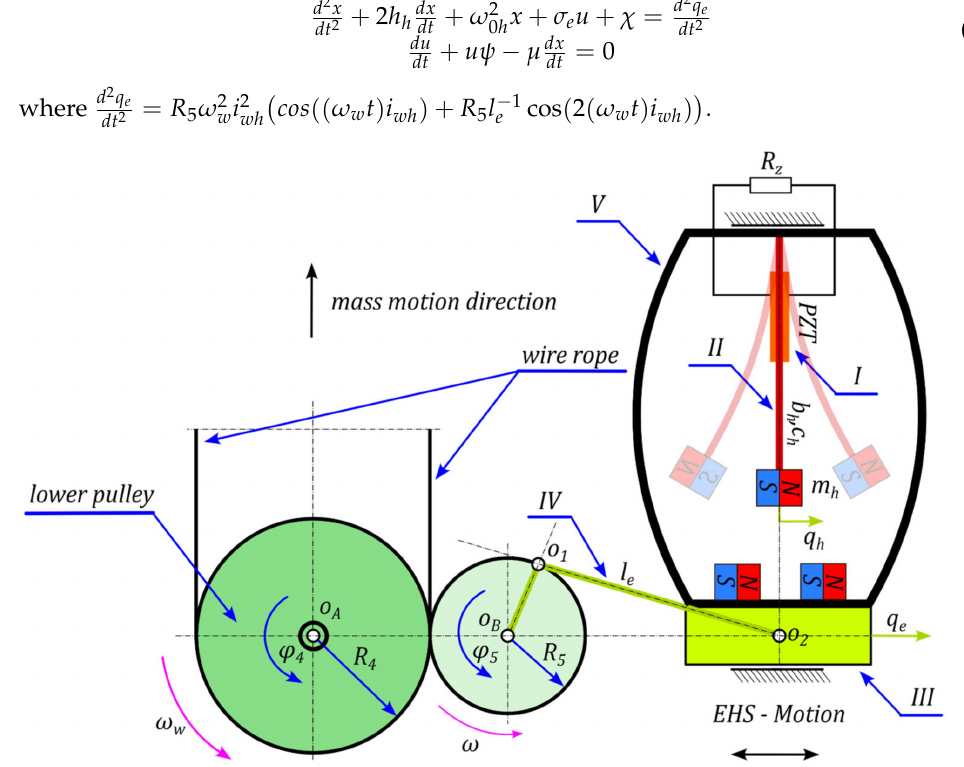
Figure 6. M-EHS (motion energy–harvesting system).